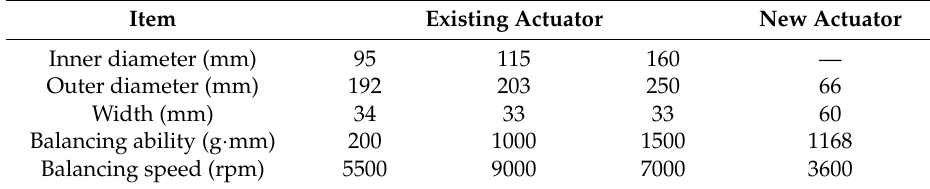
Figure 6. Working principle of existing electromagnetic-ring balancing actuator: ( a ) Physical map of the balancing actuator; ( b ) Spindle with balancing actuator; ( c ) Sectional view of balancing actuator; ( d ) Components of balancing system. Table 1. Parameter comparison between the existing actuator and the new